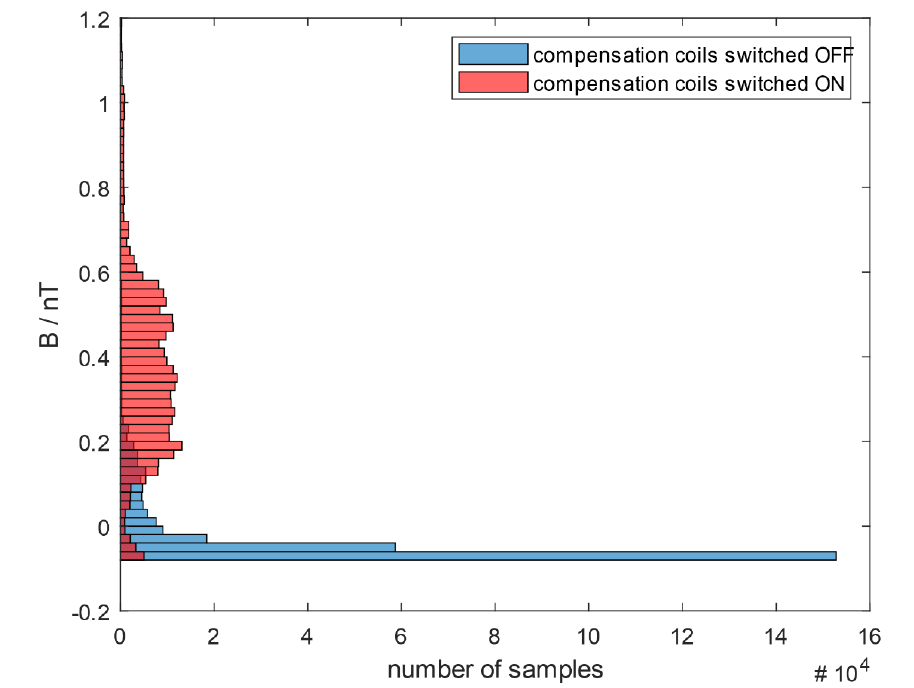
Figure 7. Distribution of magnetic induction of residual magnetic field measured with QuSpin zero field magnetometer inside the two-layer magnetically shielded room with the additional compensation coils switched off (blue) and switched on (red). The bin width was set to 0.02 nT, the number of bins: 66 (red) and 43 (blue). The skewed histogram of the measurement taken with the coils switched off (blue) with extreme dominant number of samples of magnetic induction in the range from −0.08 to −0.06 nT corresponds to the signal saturation.